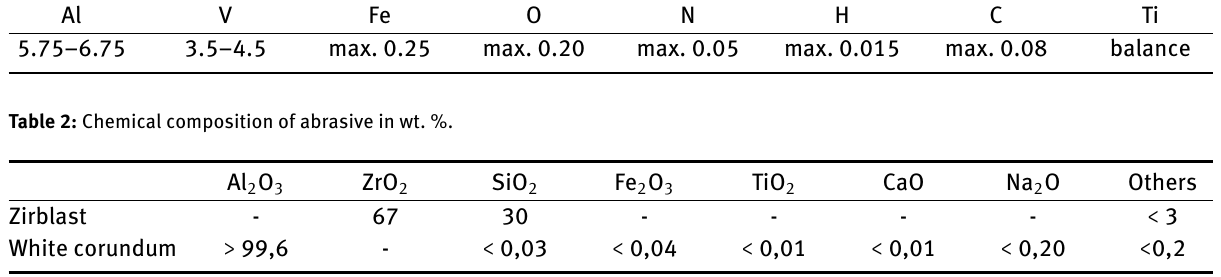
Table 1: Chemical composition of powder used [wt. %]. Al V Fe